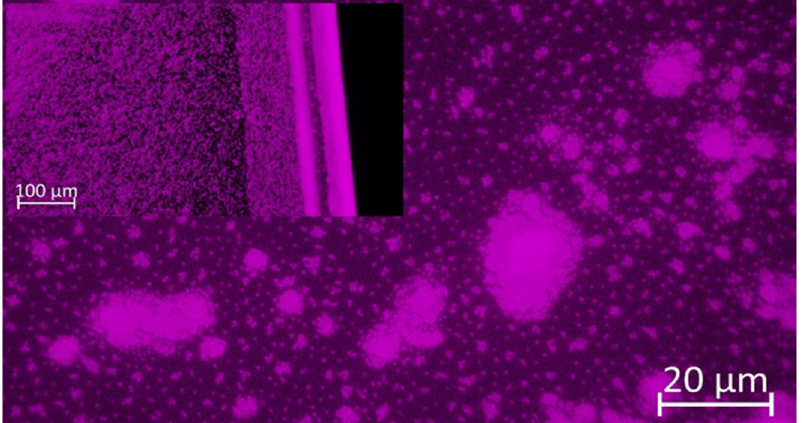
Figure 1. Microscopic image of fluorescent NPsRhB obtained in fluorescence mode ×100. Inserted image magnification ×20 taken at the edge of the measuring chamber.